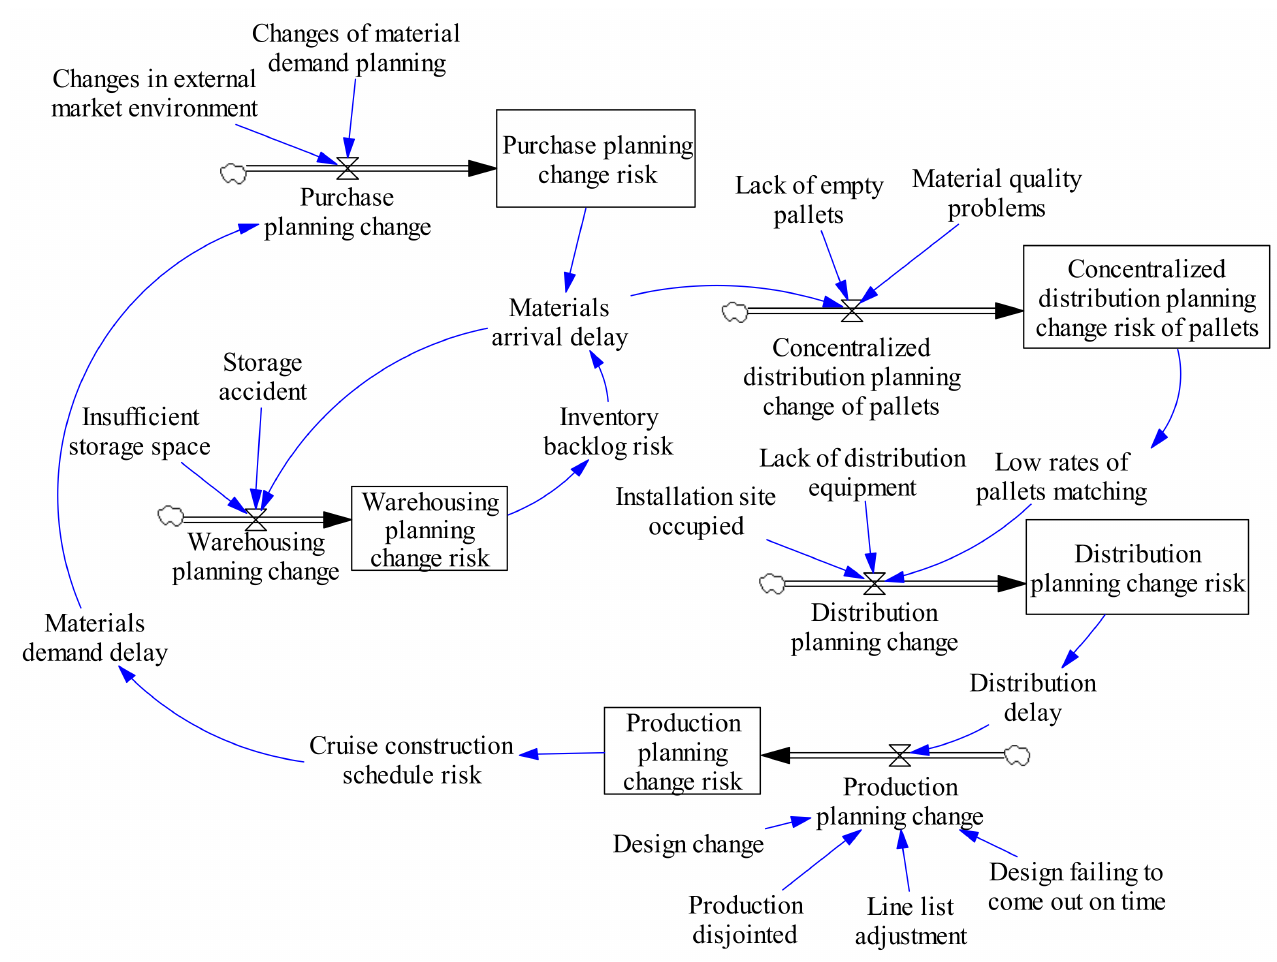
Figure 4. Stock and flow